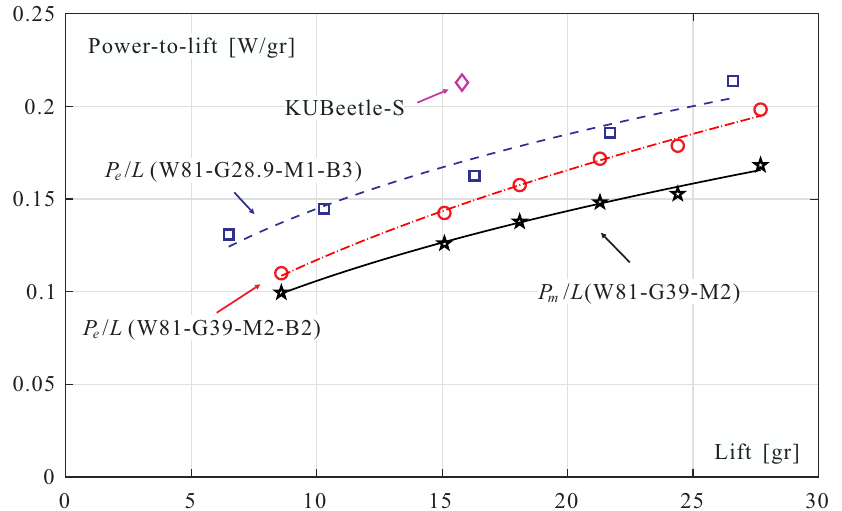
Figure 16. Power-to-lift ratio vs. Lift. P m is the mechanical power and P e is the electrical power. The value of the KUBeetle-S project is given for